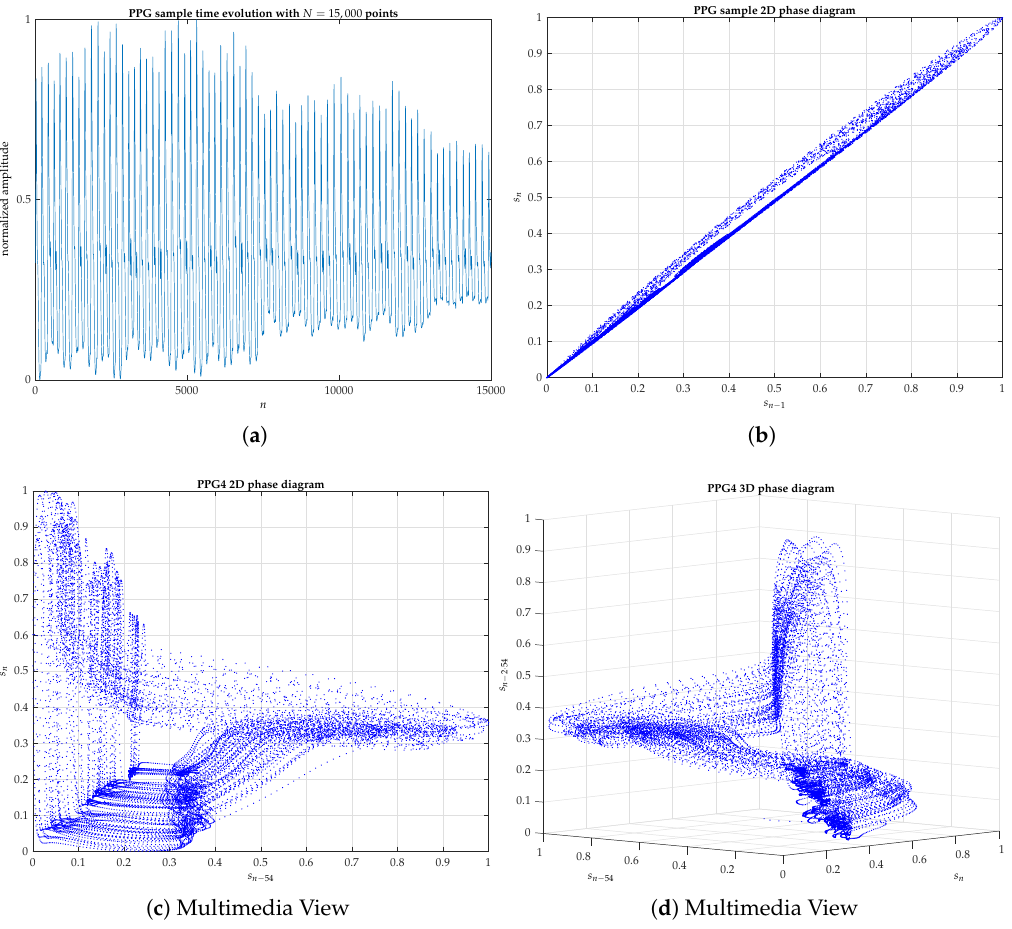
Figure A7. PPG signal of the healthy young Subject Number 4 (PPG4): ( a ) One minute PPG recorded signal. ( b ) PPG4 2D phase diagram with τ = 1. ( c ) PPG4 2D phase diagram with τ = 54, according to Table 1. PPG4 video clip of the evolution of phase diagram from τ = 1 to τ = 150 in 2D. ( d ) PPG4 3D phase diagram with τ = 54. PPG4 video clip of the evolution of phase diagram from τ = 1 to τ = 150 in 3D.